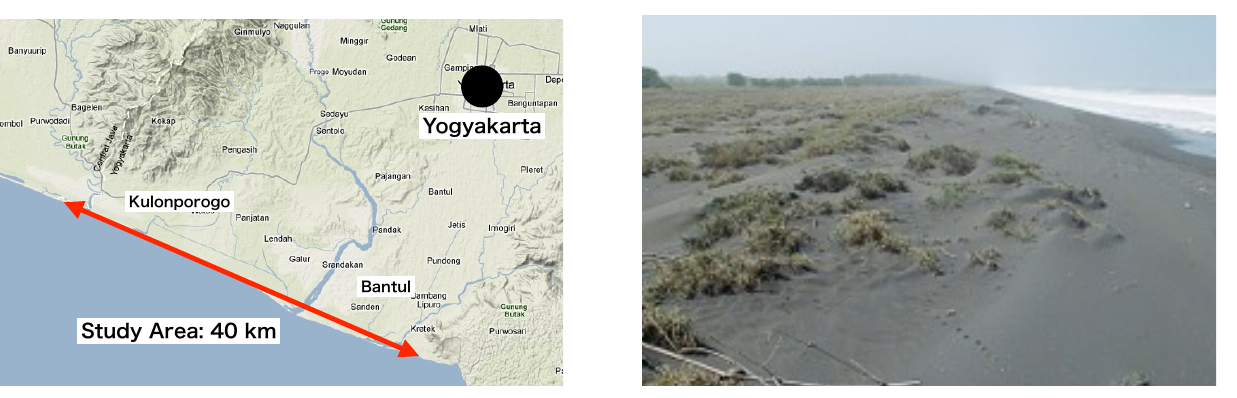
Fig. 2. Study area in Yogyakarta, Indonesia